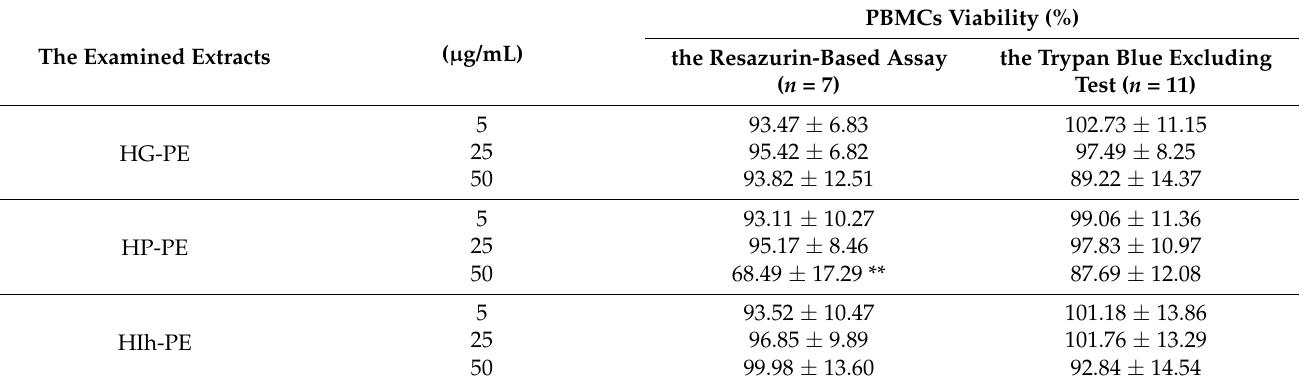
Table 3. The influence of the examined Herniaria glabra (HG-PE), H. polygama (HP-PE), and H. incana herb (HIh-PE) purified extracts on the viability of peripheral blood mononuclear cells (PBMCs). The viability of control (untreated) PBMCs was assumed as 100%; ** p <